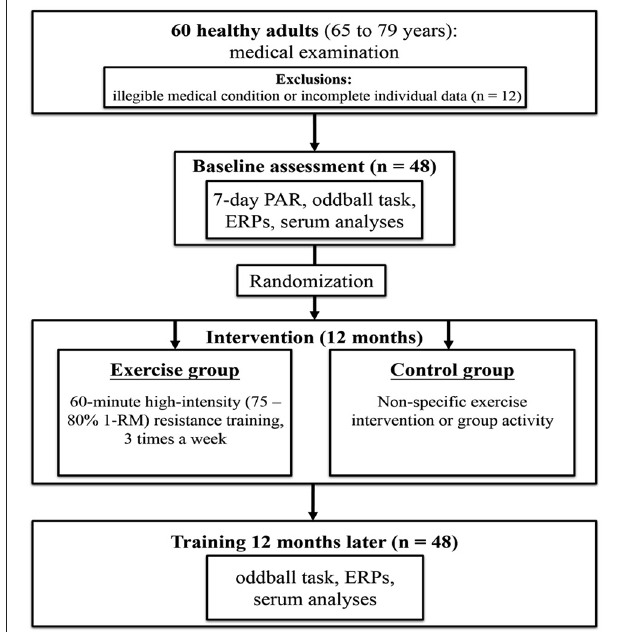
FIGURE 1 | The CONSORT (Consolidated Standards of Reporting Trials) flow